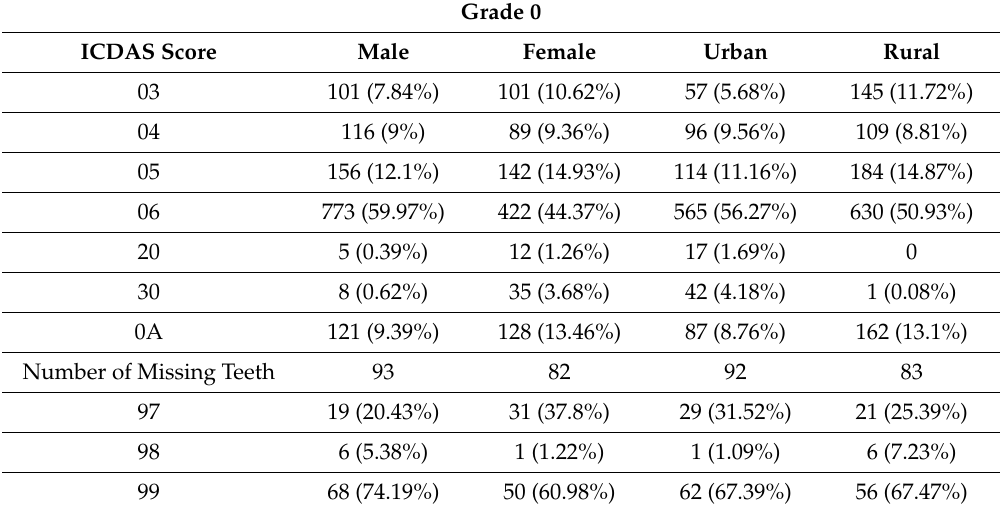
Table 2. Most frequent ICDAS scores for the 6-year-old group (percentage of total cases for male and female respectively, urban to rural; percentages calculated to the total numbers of cases for each